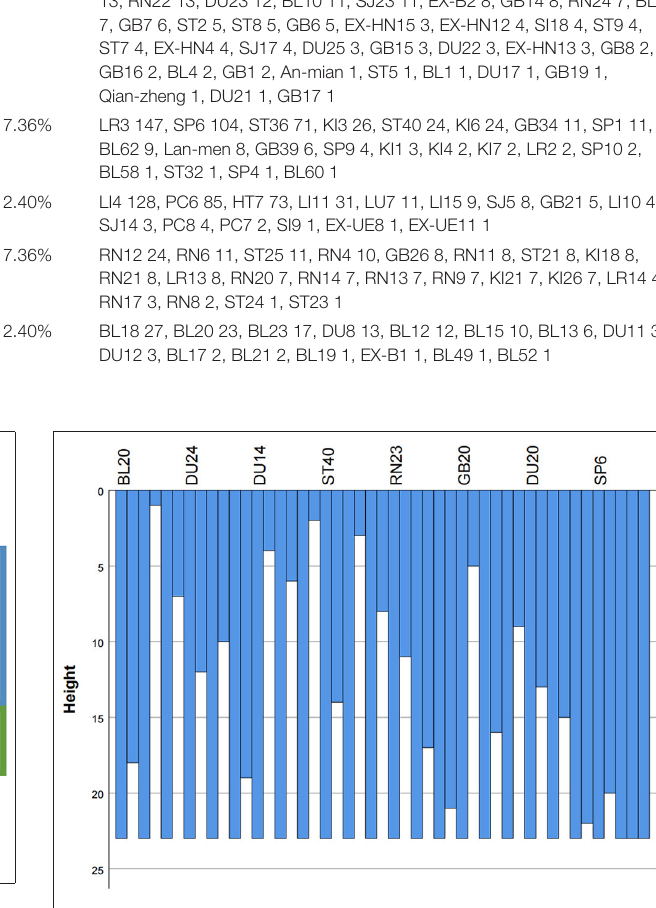
FIGURE 7 | Icicle chart of the cluster analysis of acupuncture for